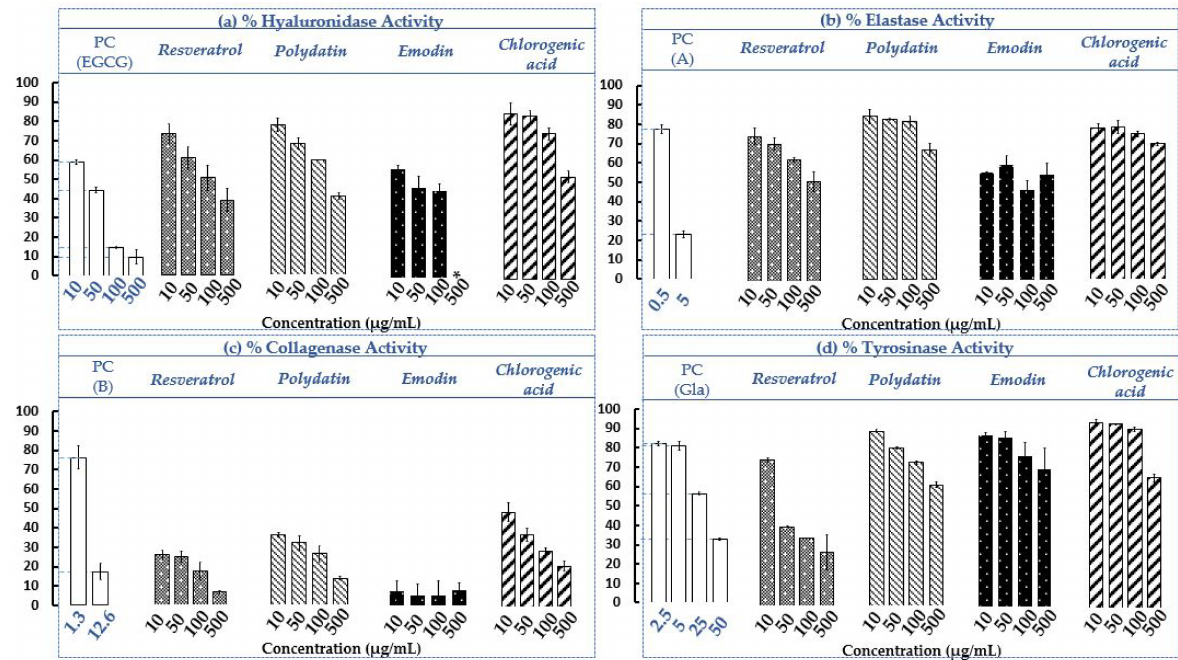
Figure 5. Evaluation of hyaluronidase ( a ), elastase ( b ), collagenase ( c ) and tyrosinase ( d ) residual activ- ities of the four selected standards: resveratrol, polydatin, emodin and chlorogenic acid. PC = Positive Control; (EGCG) = epigallocatechine gallate; (A) = N-Methoxysuccinyl-Ala-Ala-Pro-Val-chloromethyl ketone; (B) = 1,10-Phenanthroline, monohydrate and (Gla) = glabridin. n = 3 independent experiments for each concentration ( µ g/mL). Bars depict ± S.D. * NT = Not